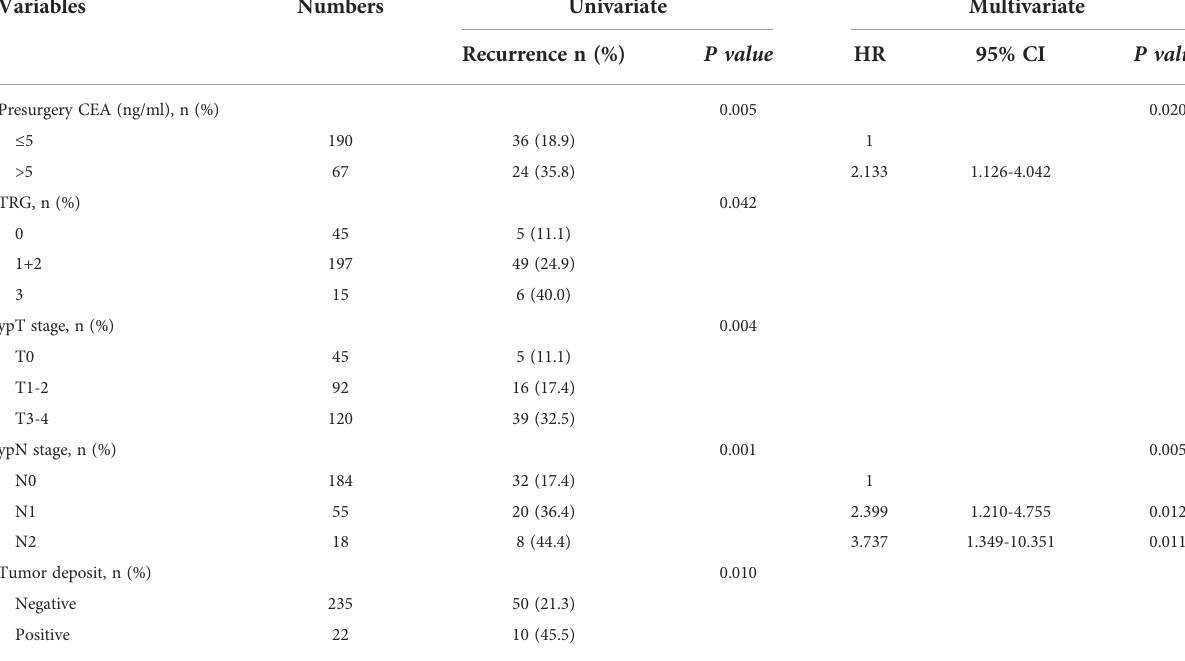
TABLE 5 Univariate and multivariate analyses of prognostic factors for